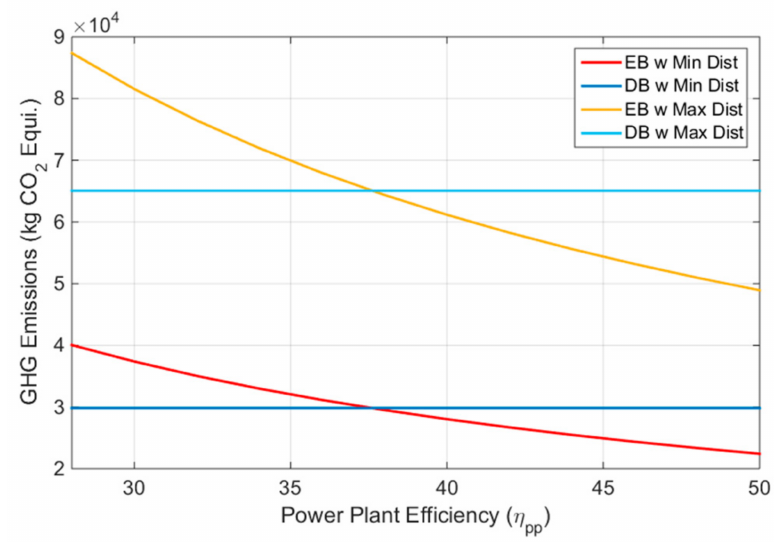
Figure 14. GHG emissions of electric and diesel buses, against power plant